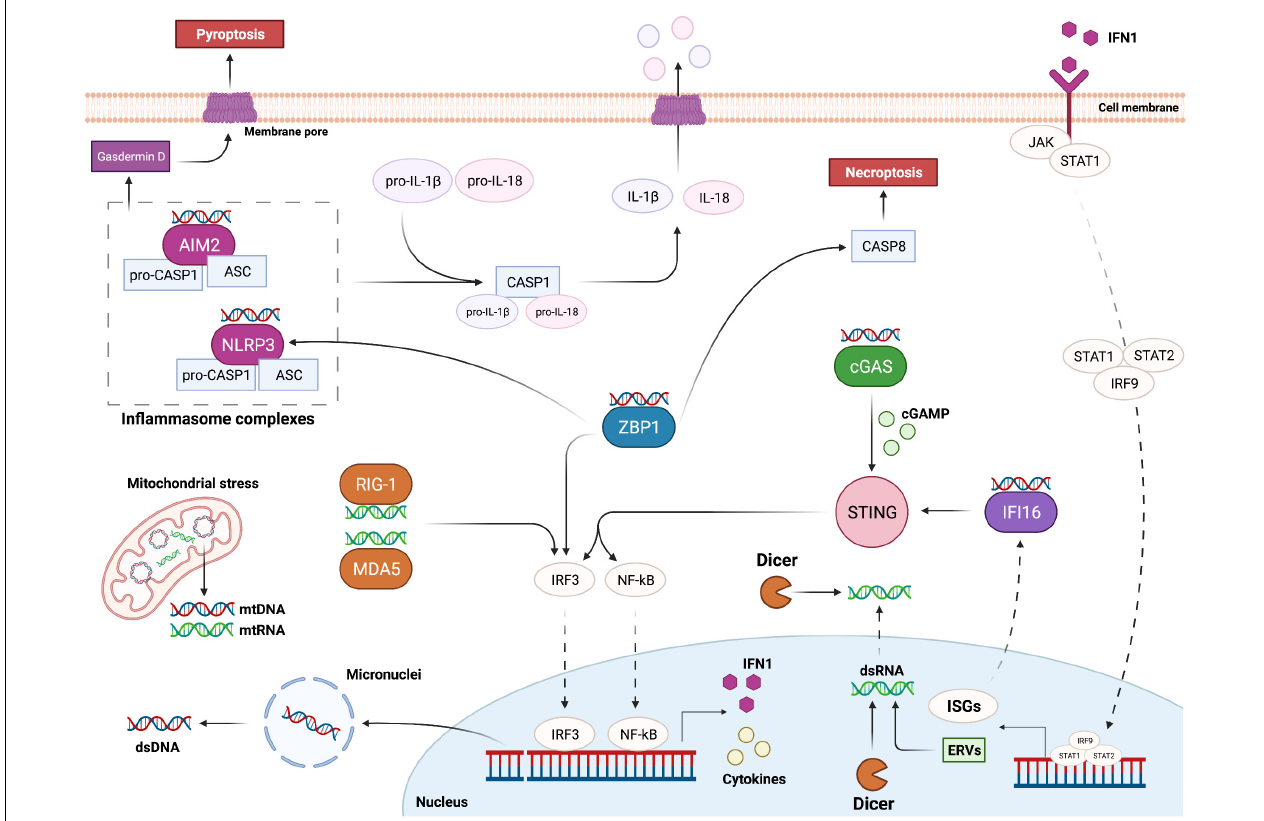
FIGURE 2 | Overview of the main pathways responsible for cytosolic nucleic acid recognition. DNA damage can trigger the formation of micronuclei and the release of double stranded DNA (dsDNA) into the cytoplasm. Mitochondria can also be a source of cytoplasmic DNA and RNA upon genomic stress. AIM2 and NLRP3 are part of two distinct inflammasome complexes, responsible for the bioactivation of Caspase-1 (CASP1); activated CASP1 in turn cleaves and promotes the activation of IL-1 β and IL-18, which leave the cell upon inflammasome-mediated pyroptosis. cGAS is the main protein responsible for cytoplasmic dsDNA recognition; upon dsDNA binding cGAS promotes the formation of cGAMP, which binds and activates STING; STING in turn promotes the activation of IRF3 and NF-kB transcription factors responsible for the expression of IFN1 and various cytokines. IFN1 is then able to leave the cell and interact with its receptor; this interaction leads to STAT1, STAT2 and IRF9 complex (ISGF3) translocation into the nucleus and transcription of interferon stimulated genes (ISGs). ISGF3 activation can also lead to expression of ancestor endogenous retroviruses (ERVs) in form of double stranded RNA (dsRNA). Cytoplasmic dsRNA is recognized by RIG-1 and MDA5, which trigger the activation of IRF3. On the other hand, Dicer can sense and cleave both cytoplasmic and nucleic dsRNA. IFI16 is an ISG able to recognize dsDNA and activate STING. ZBP1 promotes IRF3 and NLRP3 activation, and Caspase-8 (CASP8)-mediated necroptosis upon recognition of Z forms of dsDNA.